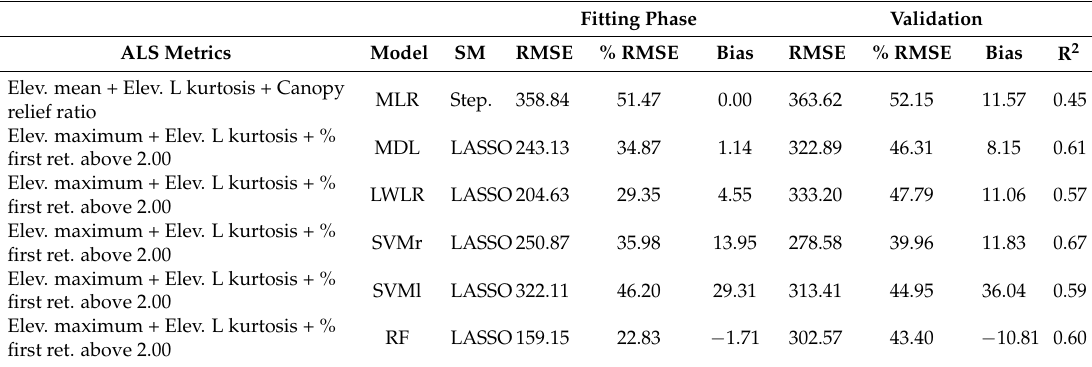
Table A3. Summary of the N models using 2016 ALS data. Validation results in terms of RMSE (stems ha − 1 ), %RMSE, and bias (stems ha − 1 ) and R 2 . SM refers to selection method; Step. stands for Stepwise both and forward; SVMr. refers to support vector machine with radial kernel; SVM l. refers to support vector machine with linear kernel; ret. refers to returns.